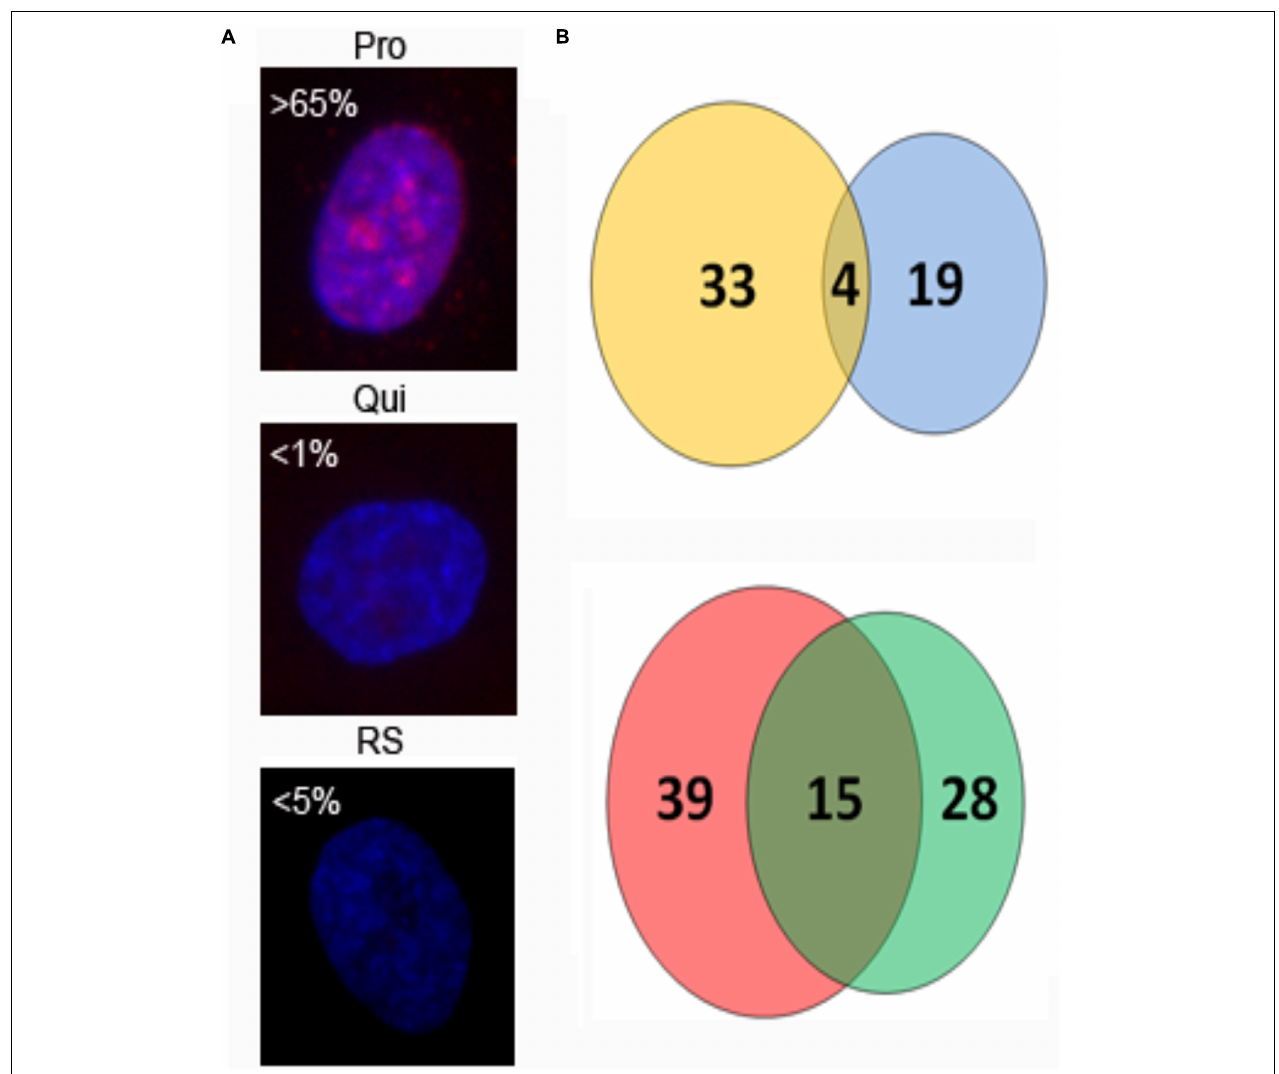
FIGURE 5 | Number of chromosome 10-associated genes with changed transcript abundance in quiescent and replicative senescent fibroblasts. 2DD fibroblast cultures were immuno-labelled for the proliferative marker Ki67 [panel (A) , red] to show growth status. Chromatin is counterstained in DAPI (blue). Percent Ki67+ cells are indicated and show the presence of Ki67 in proliferating (Pro), quiescent (Qui), and replicative senescent (RS) cultures. RNA was extracted from parallel cultures and used in microarray analysis to identify genes that had increased (B, top panel) or decreased (B, lower panel) transcript abundance from chromosome 10 as 2DD cells become quiescent or replicative senescent. Thirty three genes increased transcript levels in replicative senescent samples (yellow circle) and 19 in quiescent samples (blue circle) with 4 genes in common between the data sets. Thirty nine genes exhibited significantly decreased transcript levels in replicative senescent samples (red circle), 28 in quiescent samples (green circle) with 15 of these common between the data